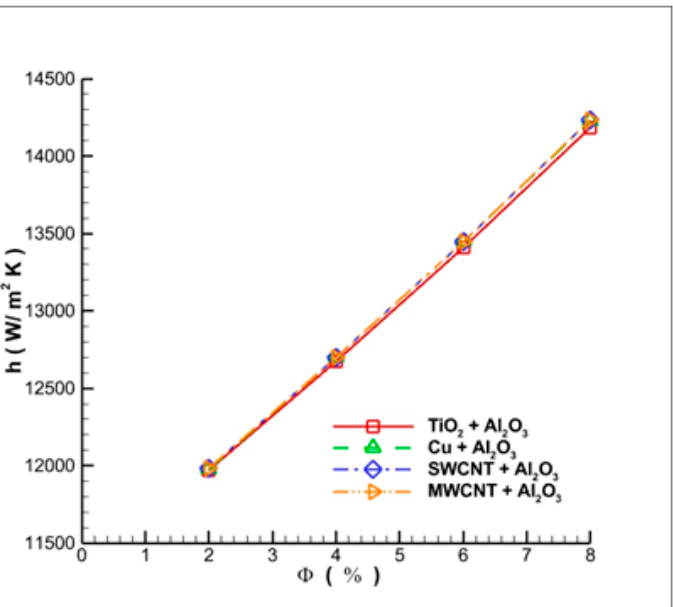
Figure 7. Variation of the convective heat transfer coefficient of the drill bit with different volume fractions of dispersed nanoparticles.